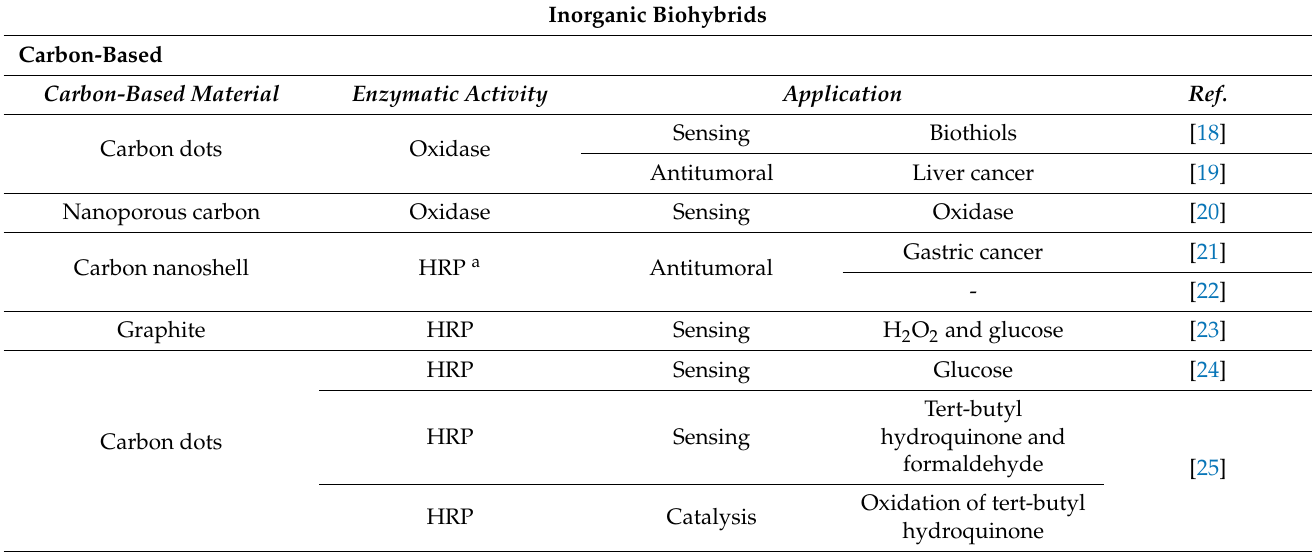
Table 1. Relevant hybrid gold-based nanozymes described in the